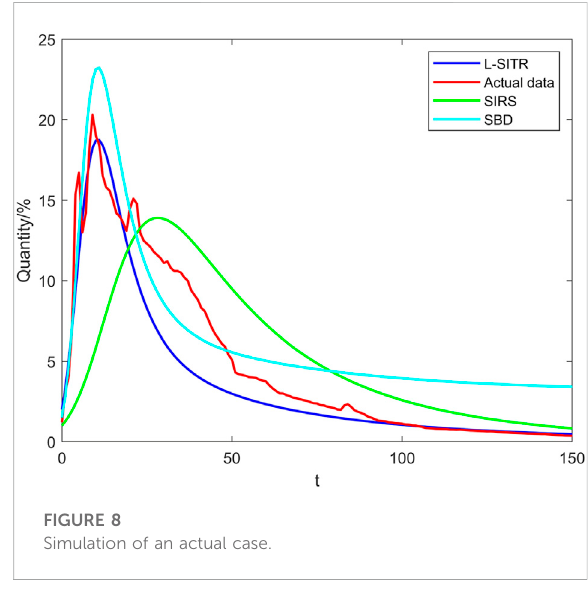
FIGURE 8 Simulation of an actual case.